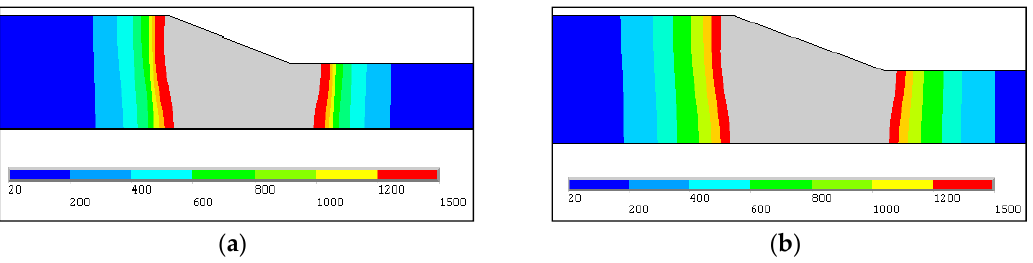
Figure 10. The arrangement mode II of dual-beam laser: dual-beam lasers all irradiate on the thick plate, and the line connecting the dual-beam laser focused spot centers is perpendicular to the welding direction.